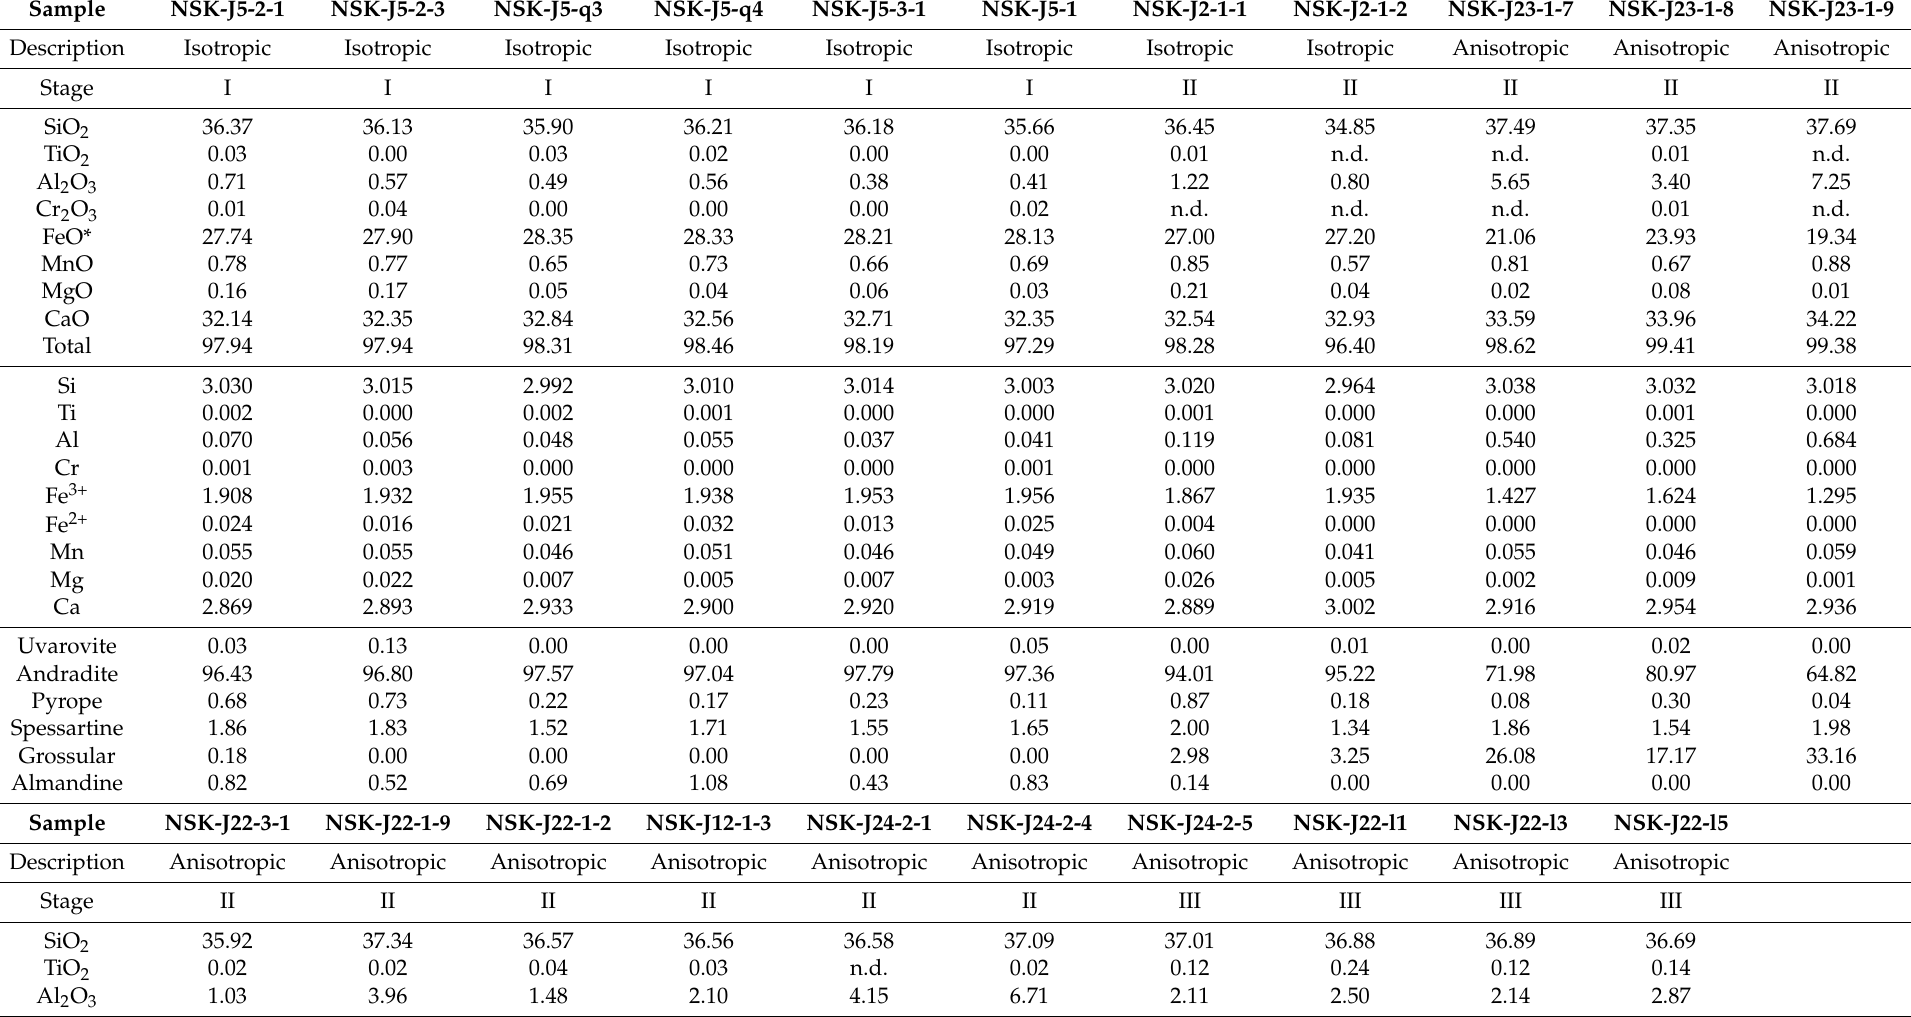
Table 1. Representative electron microprobe analyses for studied garnet with oscillatory